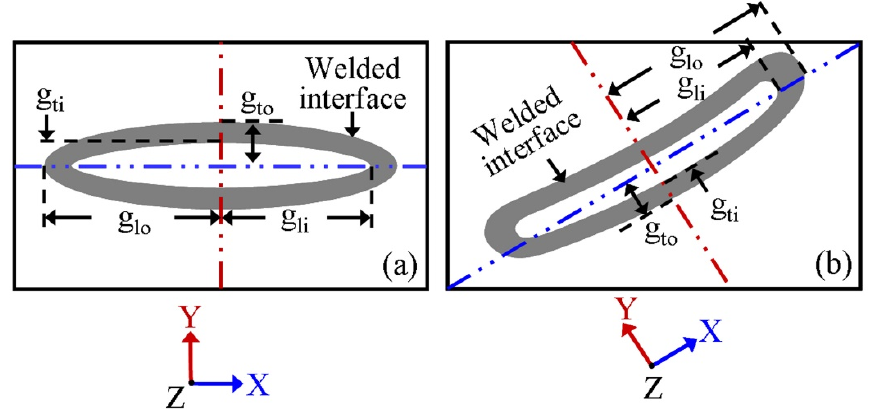
Figure 9. Schematic representation of the weld interface over the target for MPW of sheets using ( a ) rectangular- and ( b ) O-shaped flat coils.